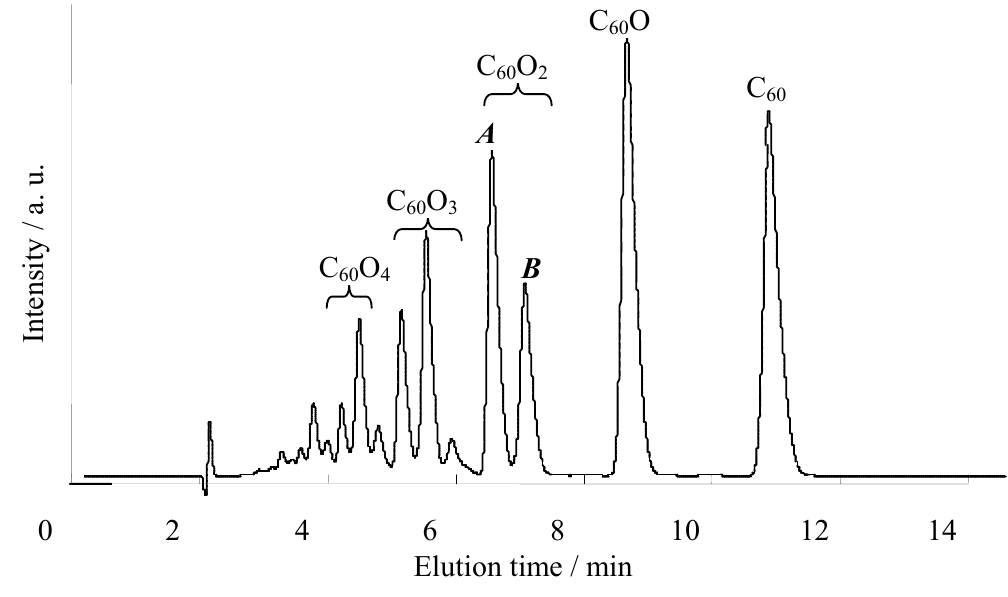
Figure 2. HPLC reversible-phase chromatograms (Develosil C30 RPFULLERENE, 34:66 acetonitrile/toluene, 335 nm detection) for reaction mixtures resulting from the m -CPBA of C (in toluene, 80  C, 30 60